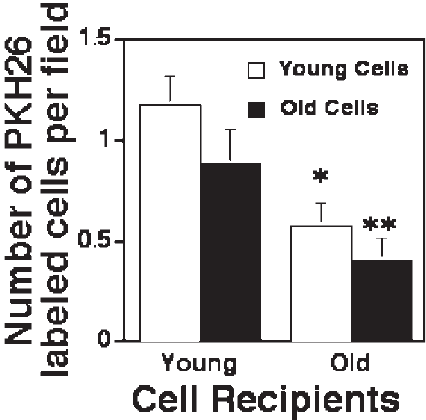
FIGURE 2 The number of PKH26 fluorescent-labeled mesenteric lymph node cells isolated from young or old donor rats, transferred intravenously into young or old recipient animals and localized to the small intestinal LP by quantitative fluorescence microscopy. The values represent the mean ^ SD of fluorescent-labeled cells 20h following adoptive transfer. The value for young cells into young recipients is significantly greater than those for either (A) young cells into old recipients (*) or (B) old cells into old recipients (**). Values represent the mean ^ SEM for 4–8